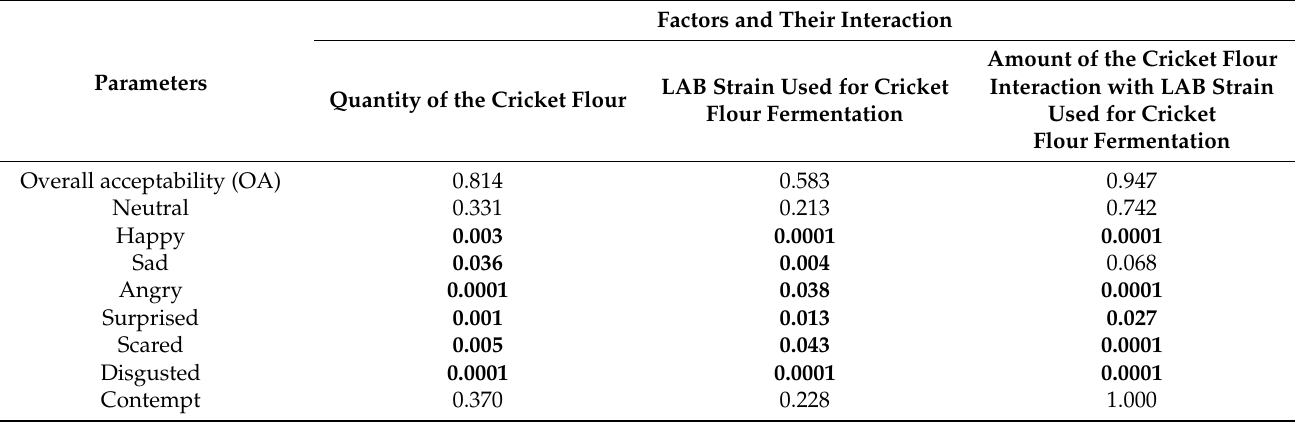
Table 8. Influence of analysed factors and their interaction on overall acceptability (OA) of biscuits and emotions induced by biscuit samples in the judge